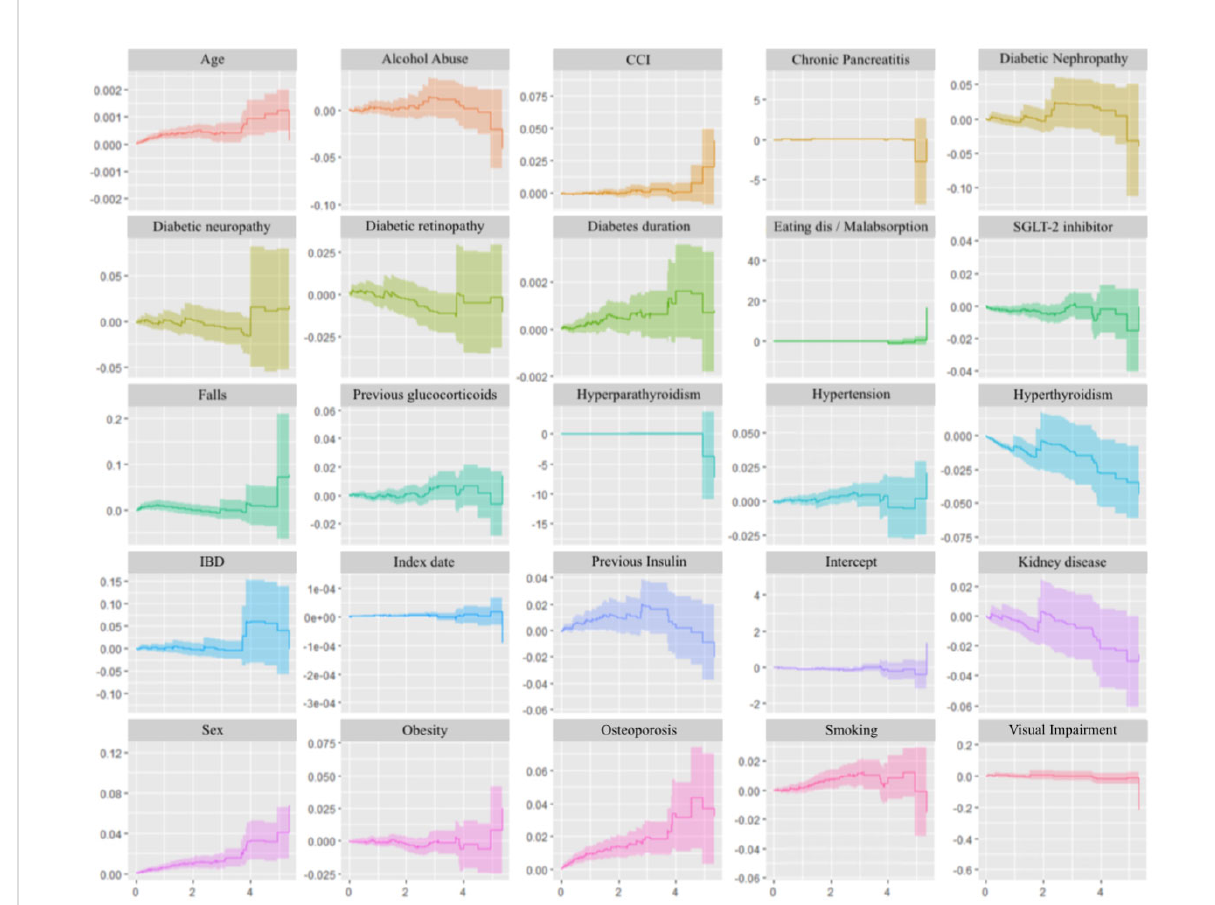
FIGURE 3 Aalen ’ s Additive Regression Plots. Plots of the time-varying additive hazards plotted against time (years) on the x-axis for covariates used in Aalen ’ s Additive Regression Model. CCI, Charlson Comorbidity Index; Eating dis, eating disorder; IBD, in fl ammatory bowel disease. This regression model assumes that the risks attributable to each risk factor are additive (producing hazard rate differences) rather than multiplicative (hazard rate ratios). Each plot shows the cumulative hazard associated with a given covariate at each time point – the slopes at any point in time represent hazard rates, and positive slopes correspond to increased risk, whereas negative slopes correspond to reduced risk. As all effects are allowed to be time-varying, a covariate may at one timepoint increase risk and a reduce risk at another timepoint. The intercept term represents a baseline hazard; i.e., the hazard when the contributions from all covariates (including exposure) are